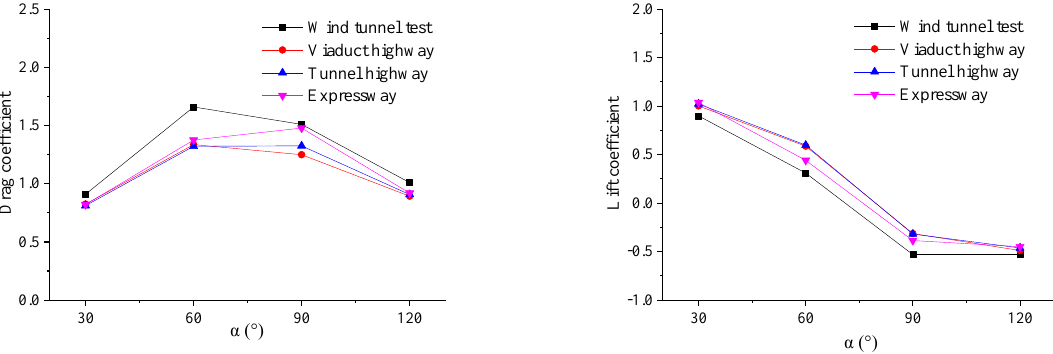
Table 5. The minimum drag and lift coefficients repeatability errors are 0.45 × 10 − 2 and 0.46 × 10 − 2 , respectively. The maximum drag and lift coefficients repeatability errors are 5.98 × 10 − 2 and 5.58 × 10 − 2 , respectively. The repeatability errors are within ± 6%, thus verifying the good repeatability of the transiting tests carried out and the high precision of